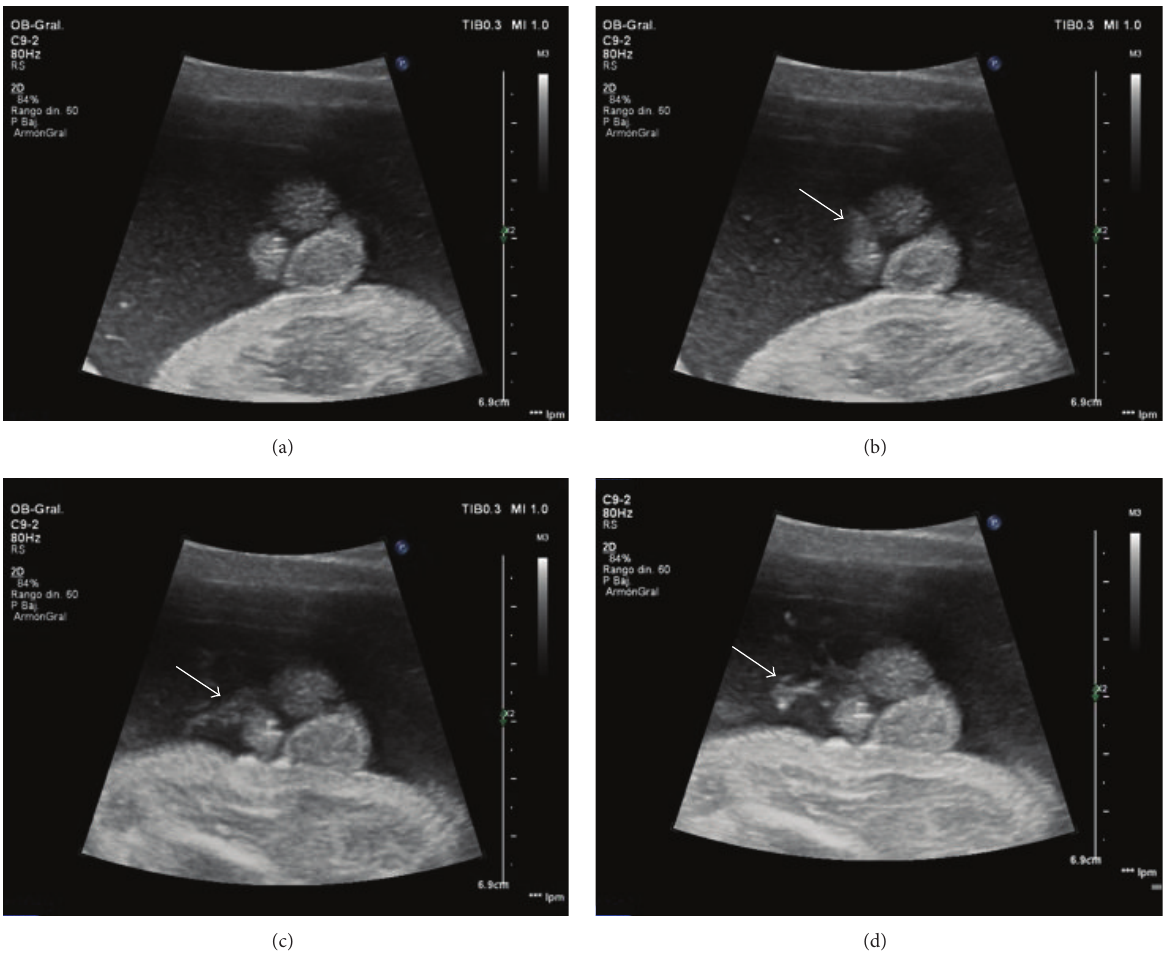
Figure 3: Consecutive sonographic images of the fetal micturition, achieved after external stimulation, which allow us to see the ventral urinary jet (arrows) near the penile base.